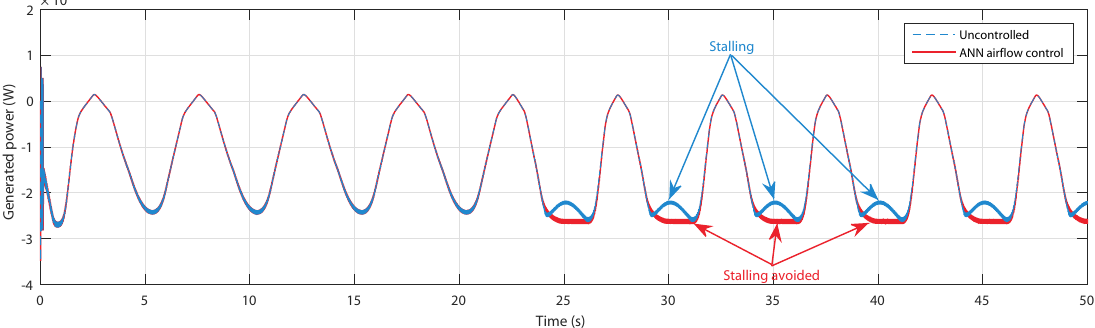
Figure 18. Generated power for uncontrolled case and ANN-based airflow control.